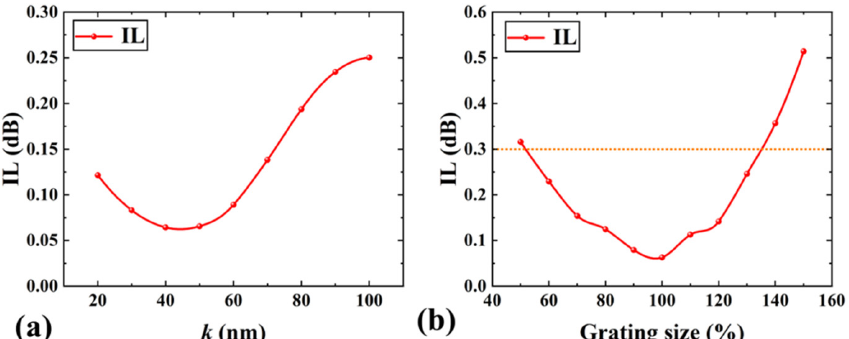
Figure 9. Fabrication tolerance analyses. IL dependence on ( a ) the width increment k of the inverse-tapered SWG for the proposed device and ( b ) the grating size variation. A grating size of 100% corresponds to the optimum widths along the x - and y -directions. A grating size of 120% corresponds to grating width increments relative to the optimum widths along the x - and y -directions. The horizontal line represents IL = 0.3 dB.